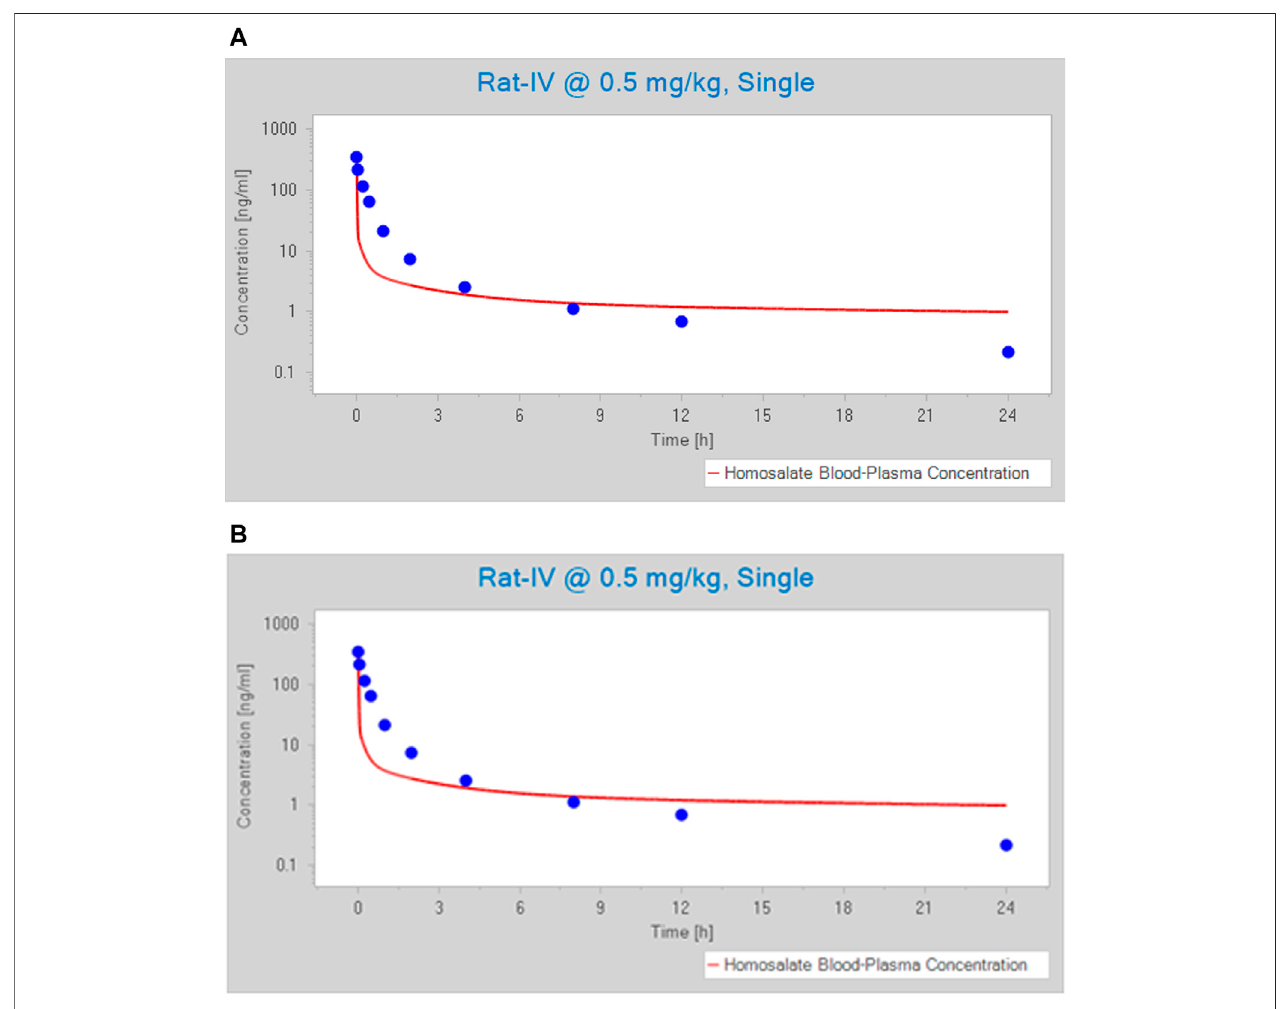
FIGURE 1 | Predicted versus observed (blue circles) concentration-time pro fi le of homosalate after an IV dose of 0.5 mg/ kg. Pro fi les were generated using (A) default values and (B) optimized values. The blue circles represent measured values and the red line denoted a simulated pro fi le.